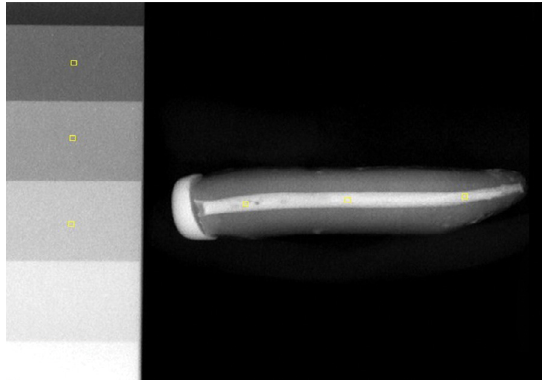
Figure 2. Regions of interest (ROI) in the coronal, middle and apical thirds of roots filled with the intracanal material, and in the second, third and fourth step of the aluminum